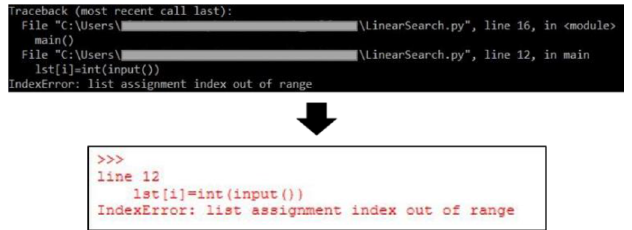
Figure 3. An example of error message simplification